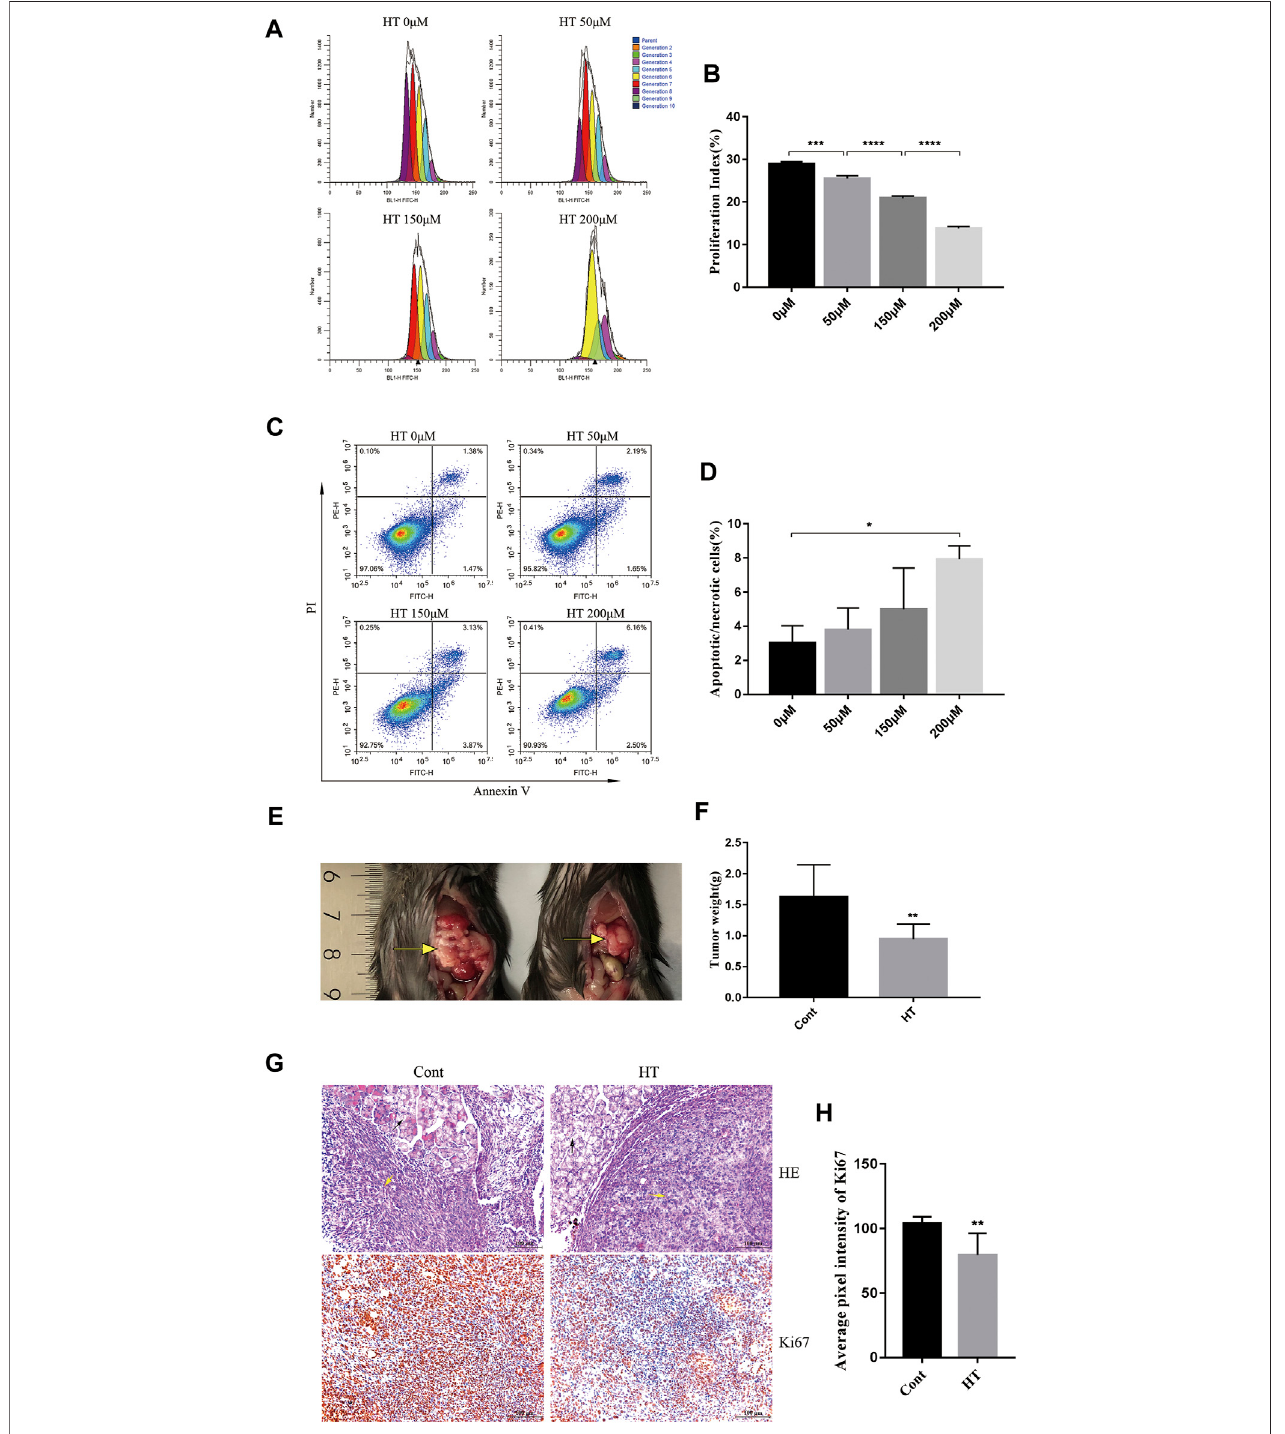
FIGURE1| Theinhibitoryeffect ofHTon mouse pancreatic cancer in vivo and in vitro . Thenumber ofgenerationsofPanc 02cells haveundergone after treatment withHT(0,50,150,200 μ M)for48 hwasdetectedusingCFSE (A) .PIwasfurthercalculatedandcompared (B) (*** p < 0.001,**** p < 0.0001).Panc02cellsweretreated withHT(0,50,150,200 μ M)for48 h,apoptoticandnecroticcells(AnnexinV+PI+/ − )weredetectedby fl owcytometry (C,D) (* p < 0.05,comparedwith0 μ M).Themice with orthotopic pancreatic tumor received HT ( n (cid:2) 9, 200 mg/kg) and normal saline ( n (cid:2) 9) intraperitoneal treatment for 10 days. Representative tumor in vivo (E) , and the tumor weight was compared (F) (** p < 0.01). Representative images of HE staining of mouse pancreatic tumor (G) , the black arrows are mouse pancrea tissue, andtheyellowarrowsarethetumortissue.Ki67expressioninmousepancreatictumorswasdetectedusingIHC.Representativeimagesandquanti fi cationofKi67from thecontrolgroupandtheHTtreatmentgroup (G,H) .Eightimagesfromfourmiceineachgroupwereanalyzedforaveragepixelintensityandstatistics (H) (** p < 0.01).All cell experiments were performed in three independent replicates.